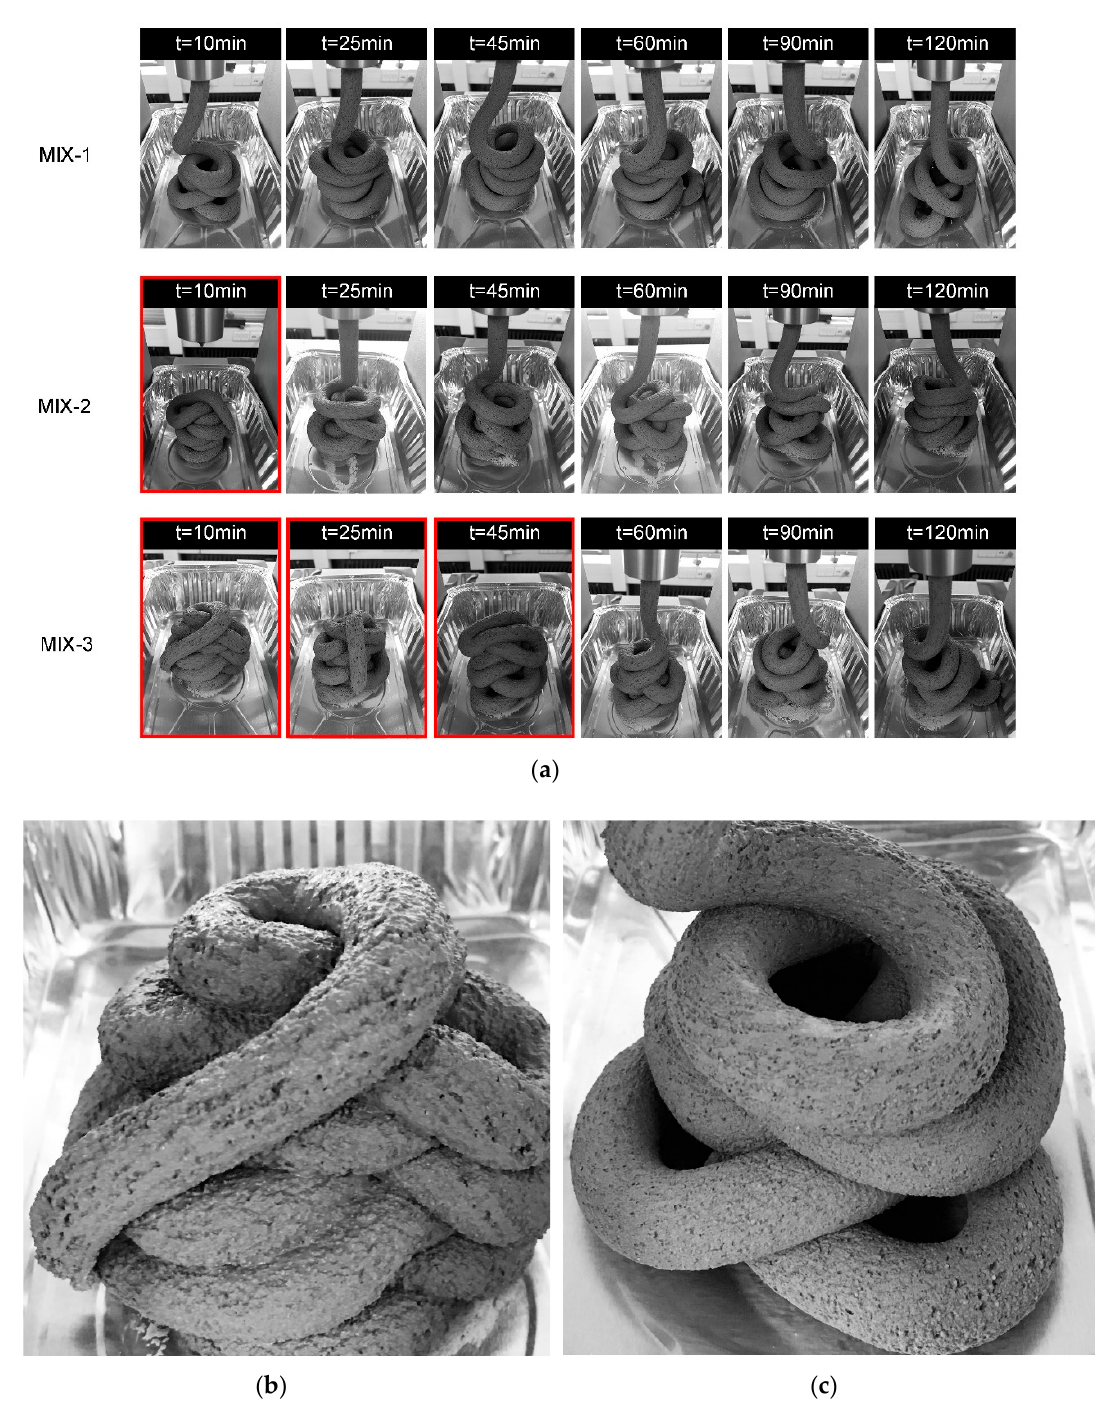
Figure 8. ( a ) Extruded filaments of mixtures MIX-1, MIX-2, and MIX-3 at different ages. The images with the red frame represent that the extruded filaments have a relatively weak shape stability, compared with others. The shape stability was evaluated by visual inspection. ( b ) An example of a relatively weak shape stability (MIX-3 at the age of 10 min). ( c ) An example of a good shape stability (MIX-1 at the age of 10 min).